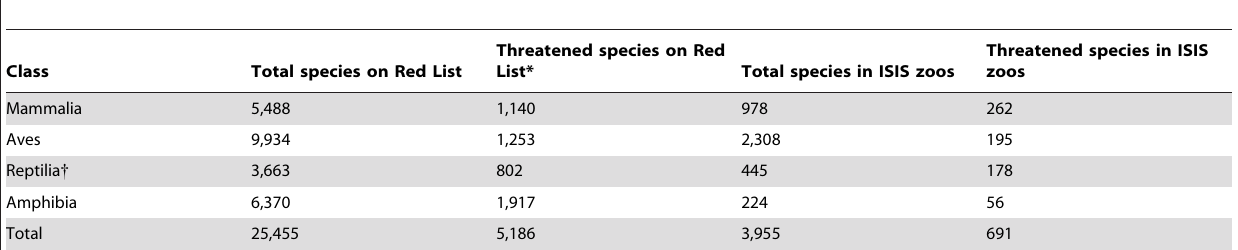
Table 1. Number of species assessed in the IUCN Red List and number of species held in ISIS zoos for each taxonomic class of terrestrial